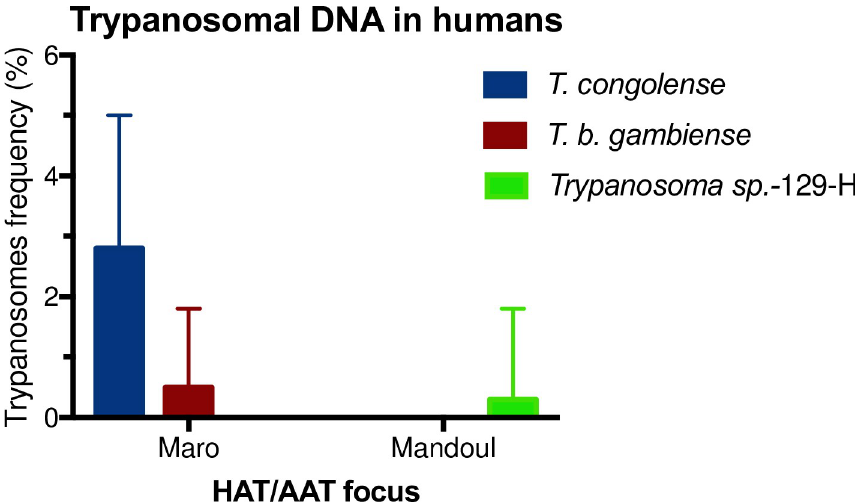
Fig 2. Trypanosomes frequency in humans in the Mandoul and Maro HAT/AAT foci. Error bars represent the upper limit of the 95% CI.